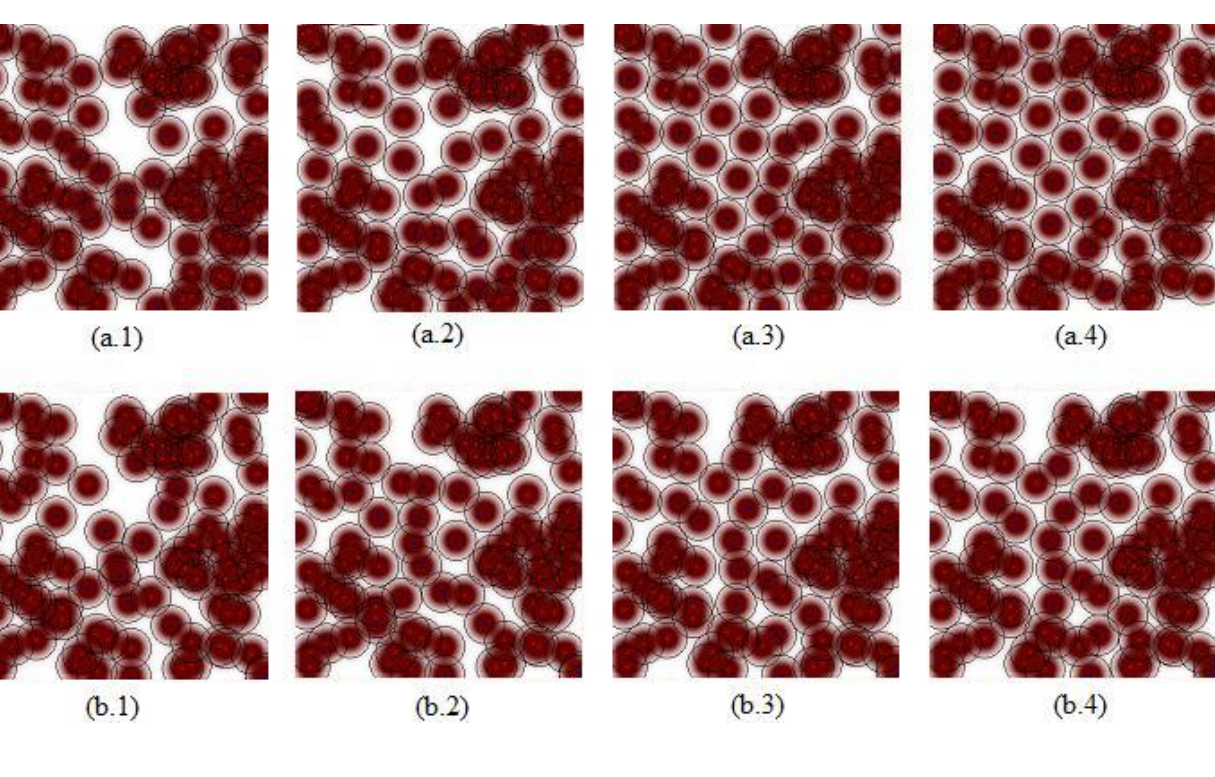
Figure 3. Best solutions of ABC: (a.1) iteration #50, (a.2) iteration # 100, (a.3) iteration # 500, (a.4) iteration # 1000. Best solutions of PSO: (b.1) iteration #50, (b.2) iteration # 100, (b.3) iteration # 500, (b.4) iteration #